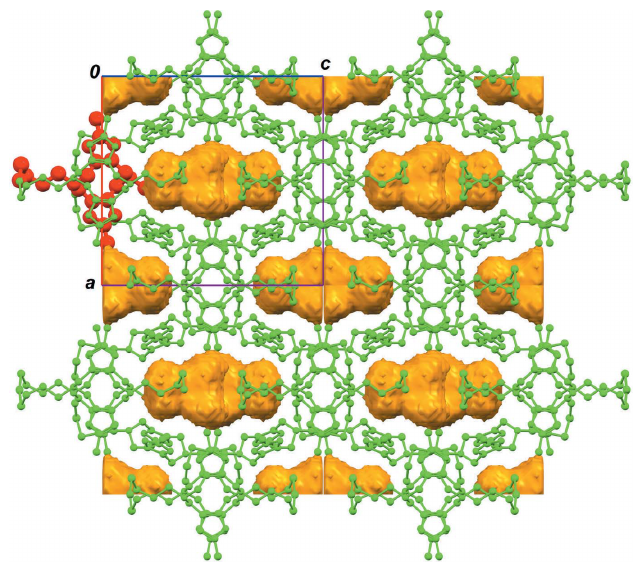
Figure 2 Part of the crystal structure of the title compound, viewed along the b axis. The minor part of the disorder and H atoms were omitted. The red molecule in the top-left unit cell includes the asymmetric unit. Void spaces in the crystal are delimited by gold surfaces calculated using the ‘contact surface’ tool in Mercury , with a probe radius of 1.2 A˚ and a grid spacing of 0.3 A˚ (Macrae et al. , 2008).